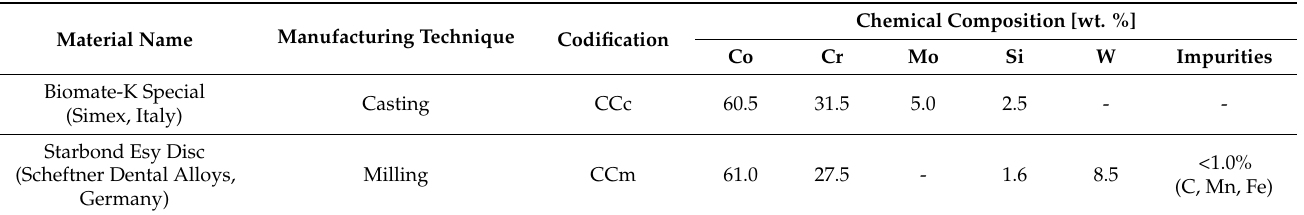
Table 1. Chemical composition specified by the manufacturer of Co-Cr alloy and sample codification.